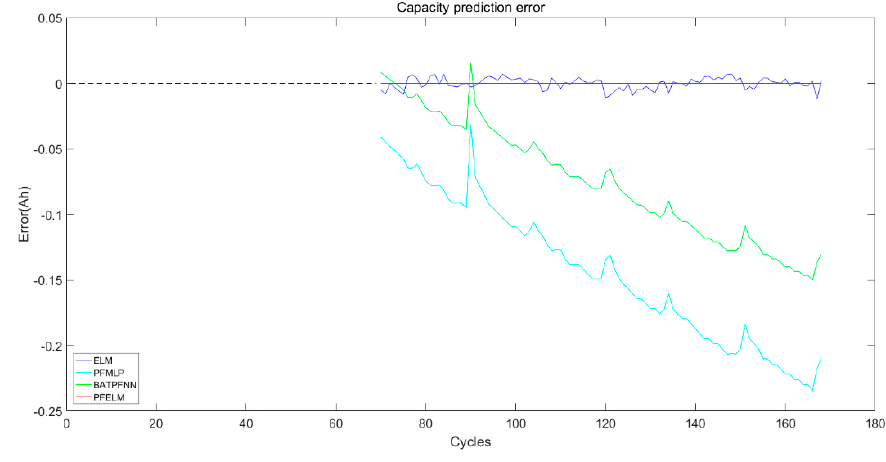
Figure 21. Capacity prediction error from the 70th cycle. Table 4. Comparison of Prognosis Results of B0007.